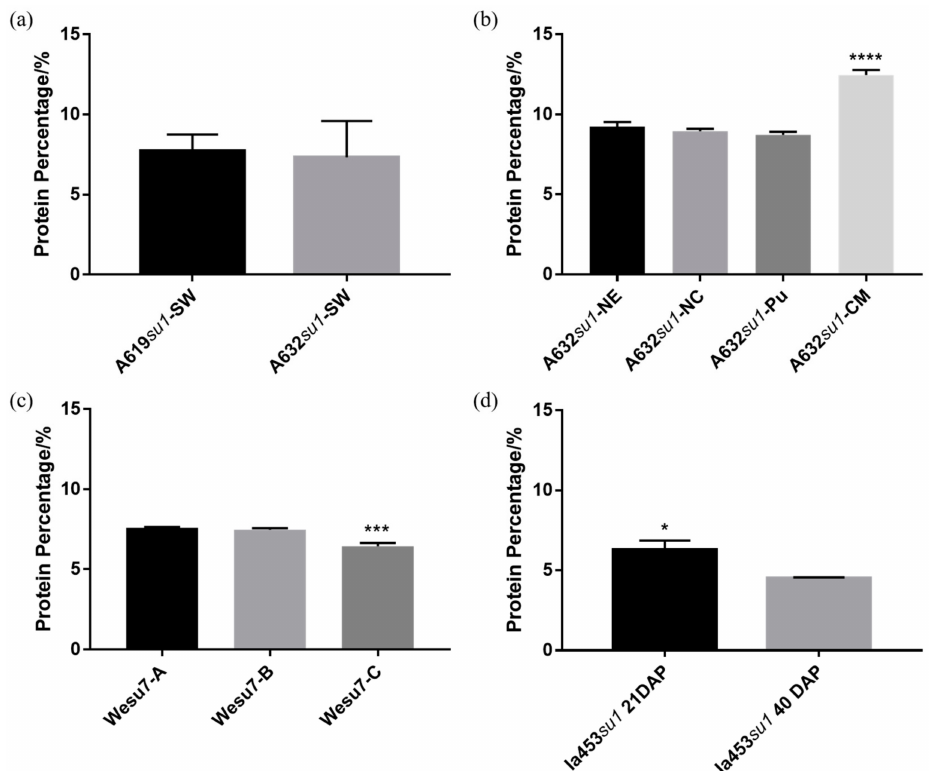
Figure 9. Protein content of phytoglycogen extracts determined using the BCA assay. ( a ) A619 su1 -SW and A632 su1 -SW, ( b ) A632 with di ff erent su1 mutants, ( c ) Wesu7-A, Wesu7-B, and Wesu7-C, and ( d ) Ia453 su1 extracted at 21 days or 40 days post-pollination. Data are presented as mean ± standard deviation ( n = 3). Statistically significant di ff erences between the means were calculated using an unpaired Student’s t test for ( a ) and ( d ). For ( b ) and ( c ) data were analyzed with one-way ANOVA followed by Tukey’s post-hoc. * p < 0.05, *** p < 0.001 and **** p <